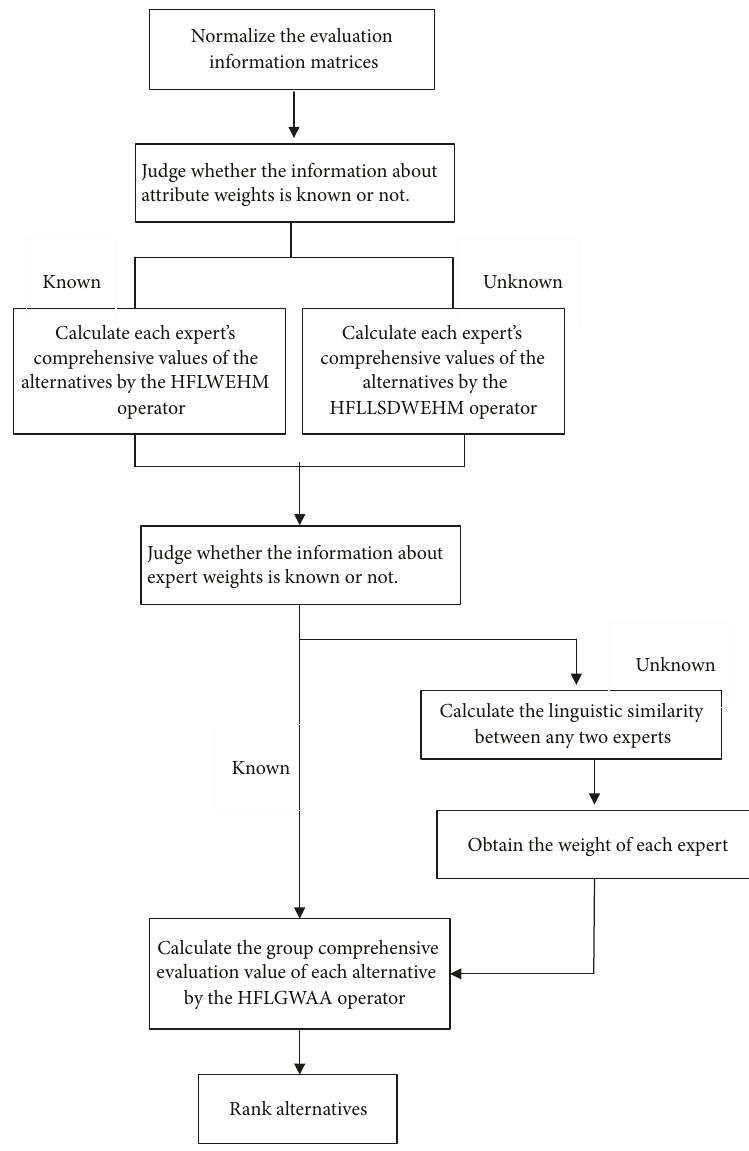
Figure 1: The flow chart of the proposed MAGDM method.